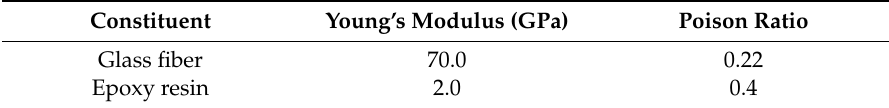
Table 1. Properties of glass fiber and epoxy resin.